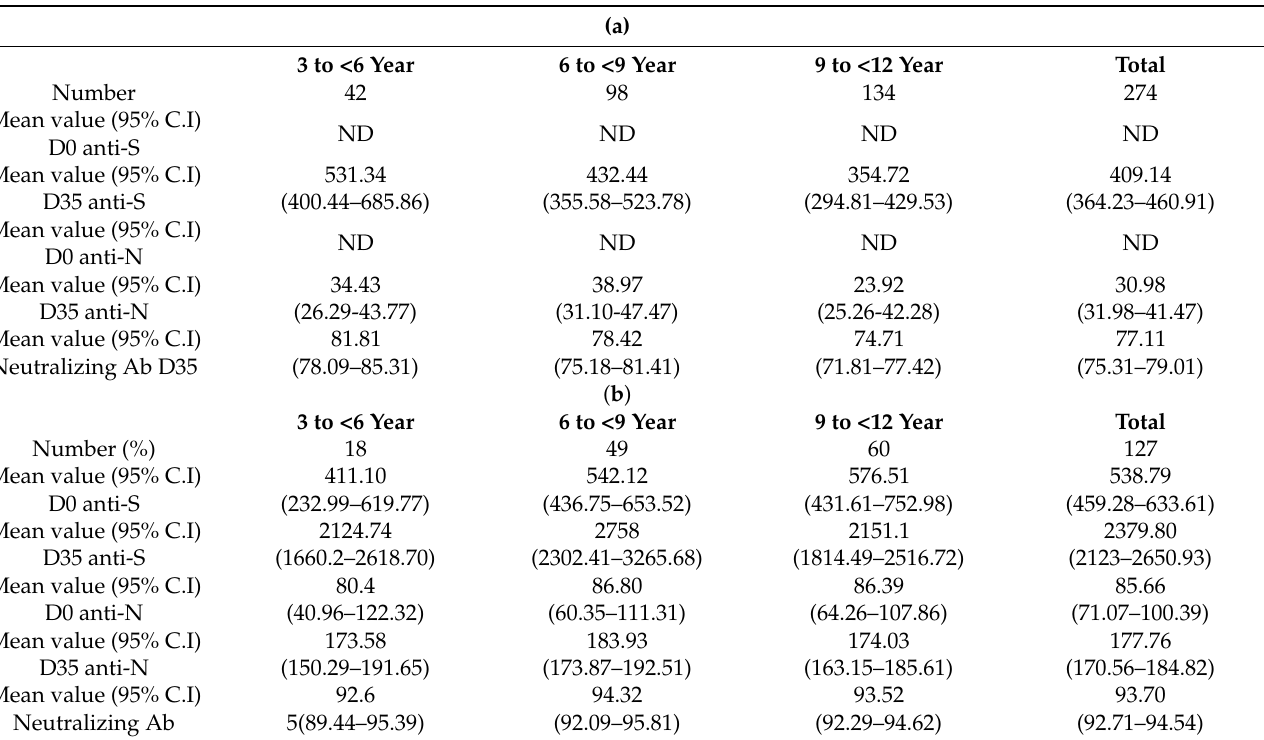
Table A3. ( a ) Ab response in different age groups in children with no previous exposure. ( b ) Ab response in different age groups in children with previous